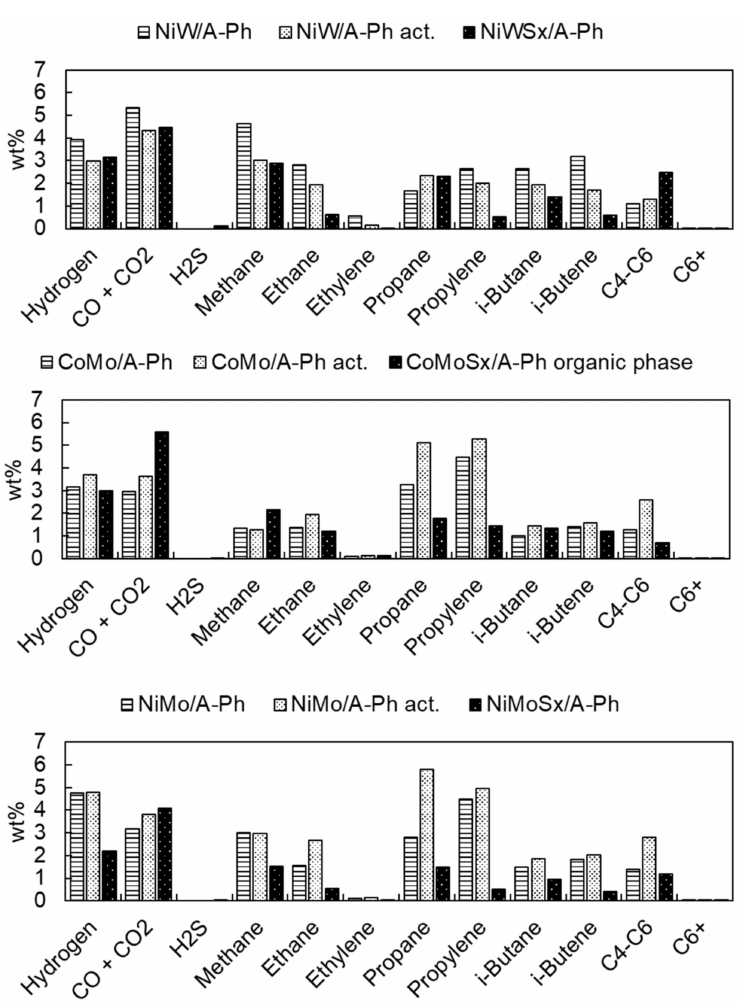
Figure 13. Refinery gas analyses (RGA) results for